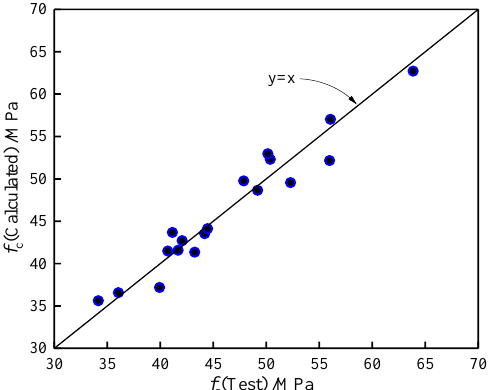
Figure 7. Comparison of f c between experimental and calculated values.